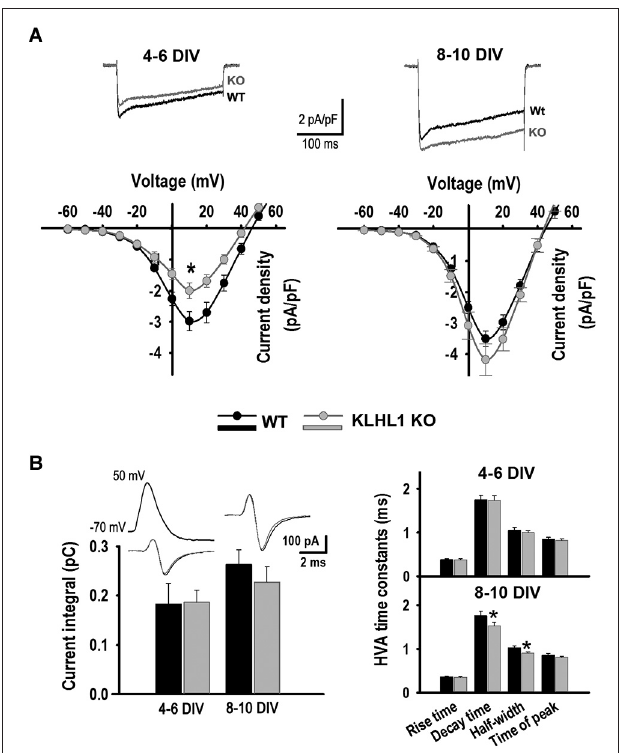
FIGURE 2 | Characterization of HVA currents . (A) Example time course response of a neuron exposed to: nifedipine (1 µ M), ω -Agatoxin IVA (400 nM) and ω -Conotoxin GVIA (2 µ M). Right: Current traces obtained before (a) and after addition of the drugs (b–d) (V T = +10 mV, V H = − 50 mV). (B) Percentage block of HVA current by antagonists in WT and KO neurons. (C) Western blot analysis of HVA channel subunits. Top: Examples of protein levels of HVA channel subunits in WT and KO hippocampus. Bottom: Quantification of α 1A , α 1C , α 1D , α 1B protein ratios (KO/WT). * p < 0.05, Student’s t -test, ** p < 0.05, paired Student’s t